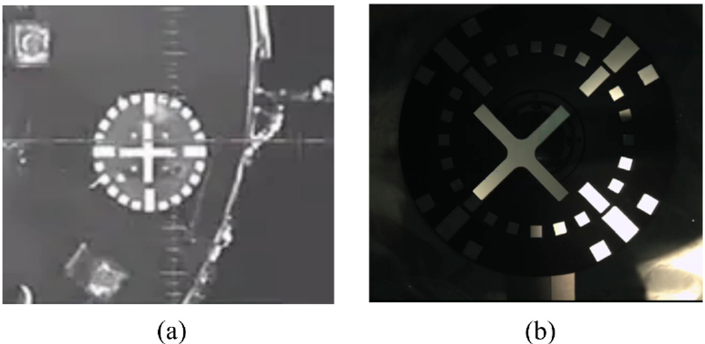
Figure 2. Shenzhou spacecraft docking visual-positioning marker ( a ) uniform lighting conditions ( b ) nonuniform lighting conditions.